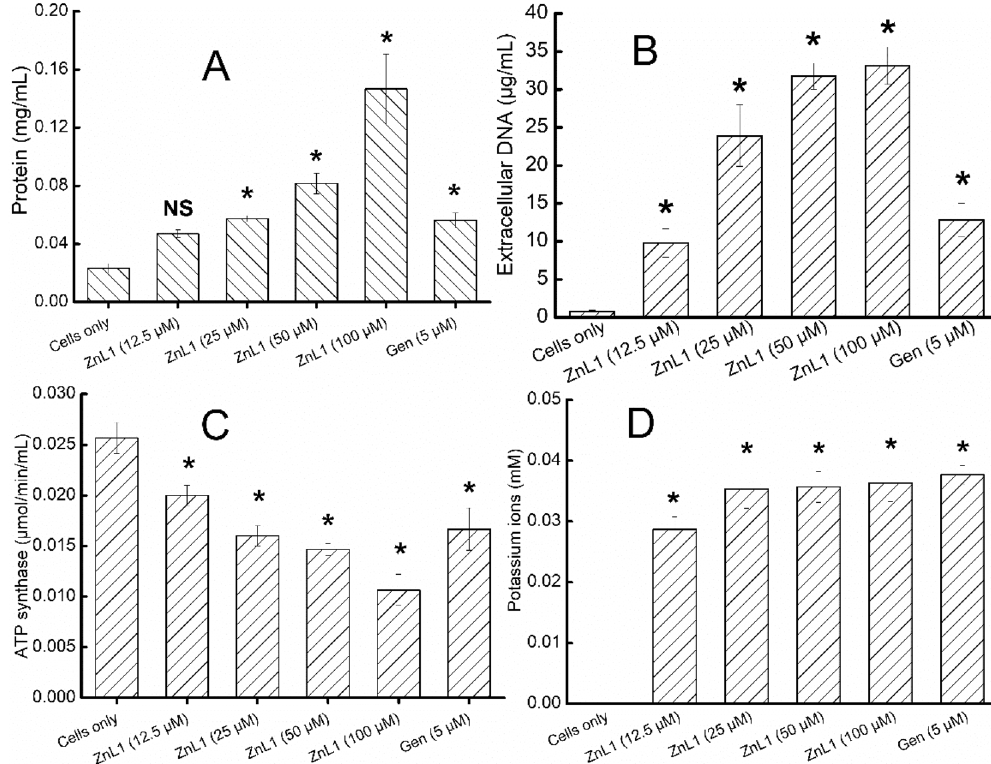
ATP synthase loss; ( D ) potassium ion leakage. Error bars represent standard deviation (SD) of at least three independent replicates. NS not significant, * significant difference between treated cells in comparison to